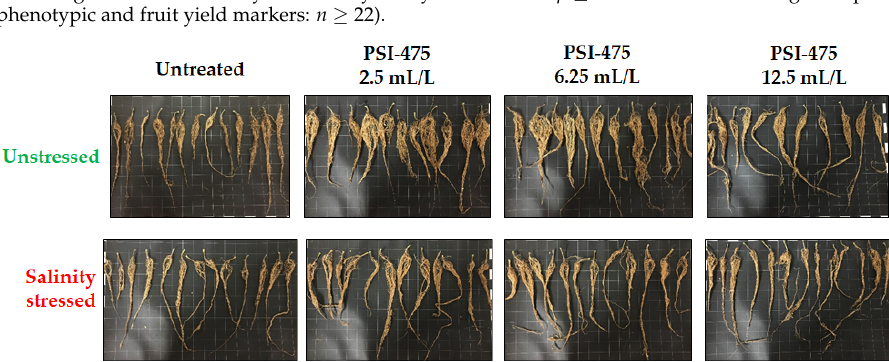
Figure 1. E ff ect of salinity and PSI-475 dosage rate on tomato root growth. Roots shown in the pictures were sampled from 10 to 12 di ff erent plants per treatment and condition.